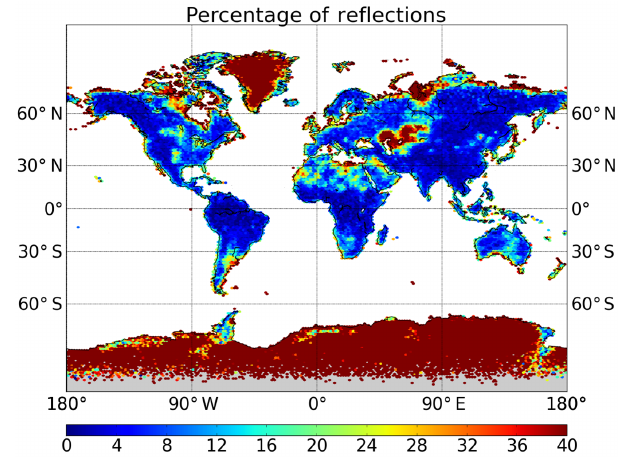
Figure 3. Map of percentage of GPSRO events identified as showing a reflection over land. The map was compiled with ∼ 1320000 land events. Reflection events, here identified as those presenting SVM > 0.25, mostly occur over smooth terrain, free of thick vegetation (deserts, tundra, grasslands), and over continen- tal ice. The largest percentages are found over the ice sheets. The colour scale is saturated at 40%. See also Movie 1, which shows the seasonal cycle of the median SVM output value over